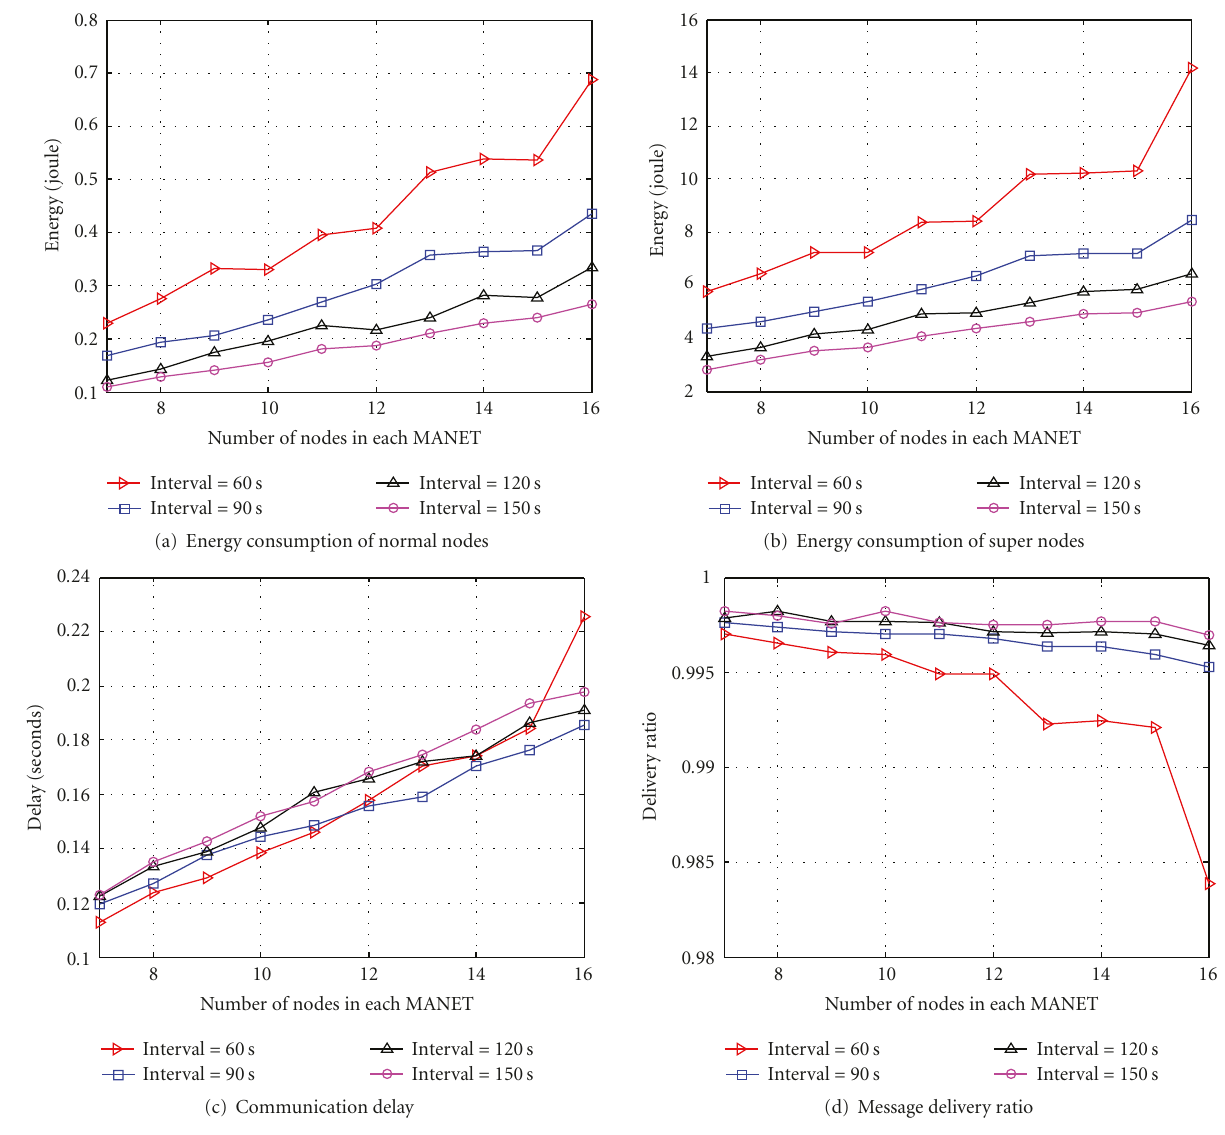
Figure 2: Simulation results of the proposed secure routing